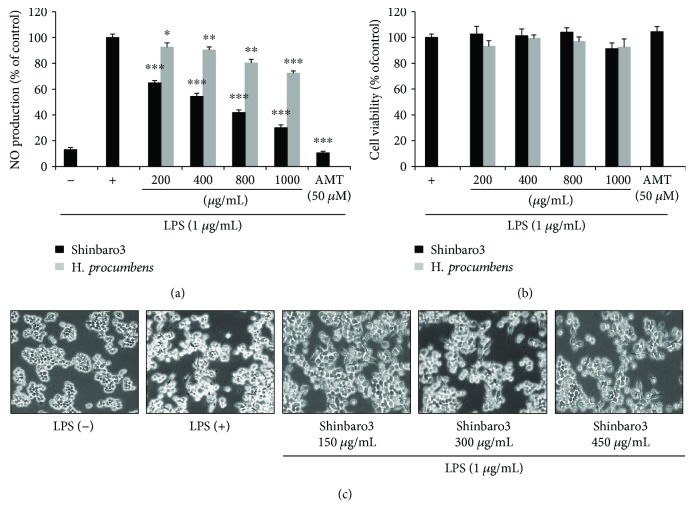
Effects of Shinbaro3 on NO production in LPS-stimulated RAW 264.7 macrophage cells. (a) RAW 264.7 cells were stimulated with LPS (1 μg/mL) for 20 h in the absence or presence of Shinbaro3 (after hydrolysis) or H. procumbens extract (before hydrolysis) (200, 400, 800, or 1000 μg/mL). The nitrite concentration in the supernatant was detected via the Griess reaction. (b) Cell viability upon Shinbaro3 or H. procumbens treatment for 20 h was evaluated using the MTT assay, as described in Materials and Methods. (c) Morphological changes produced by Shinbaro3 in LPS-stimulated macrophages, photographed with an inverted phase-contrast microscope. Data are presented as the mean ± SD (n = 3). ∗p < 0.05, ∗∗p < 0.01, and ∗∗∗p < 0.001 versus LPS treatment alone.